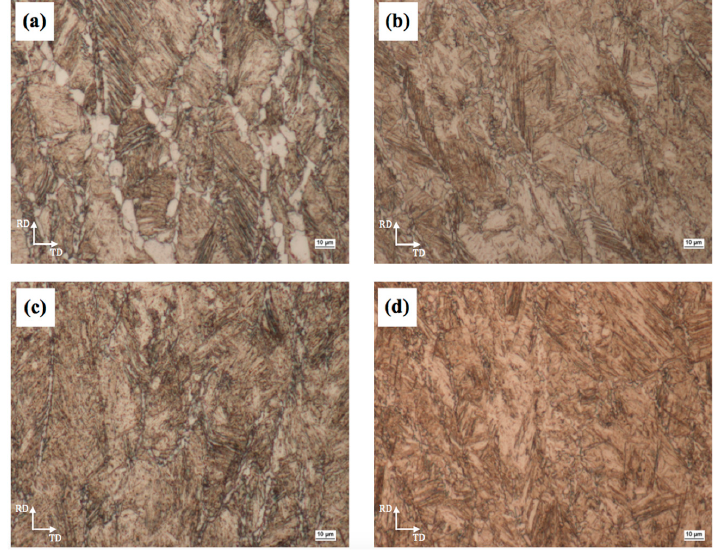
Figure 2. Effect of the FRT on final microstructures in specimens after controlled rolling with the final reduction of 50% (RD—rolling direction, TD—transverse direction): ( a ) 700 °C; ( b ) 750 °C; ( c ) 800 °C; ( d ) 850 °C.